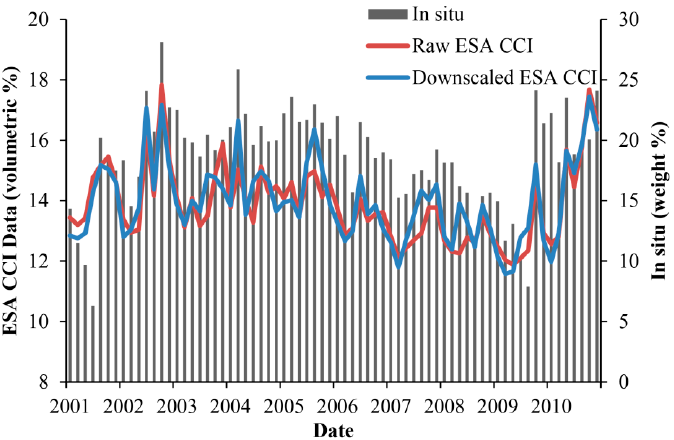
Figure 4. The monthly variations of the in situ, raw ESA CCI and downscaled ESA CCI soil moisture data.